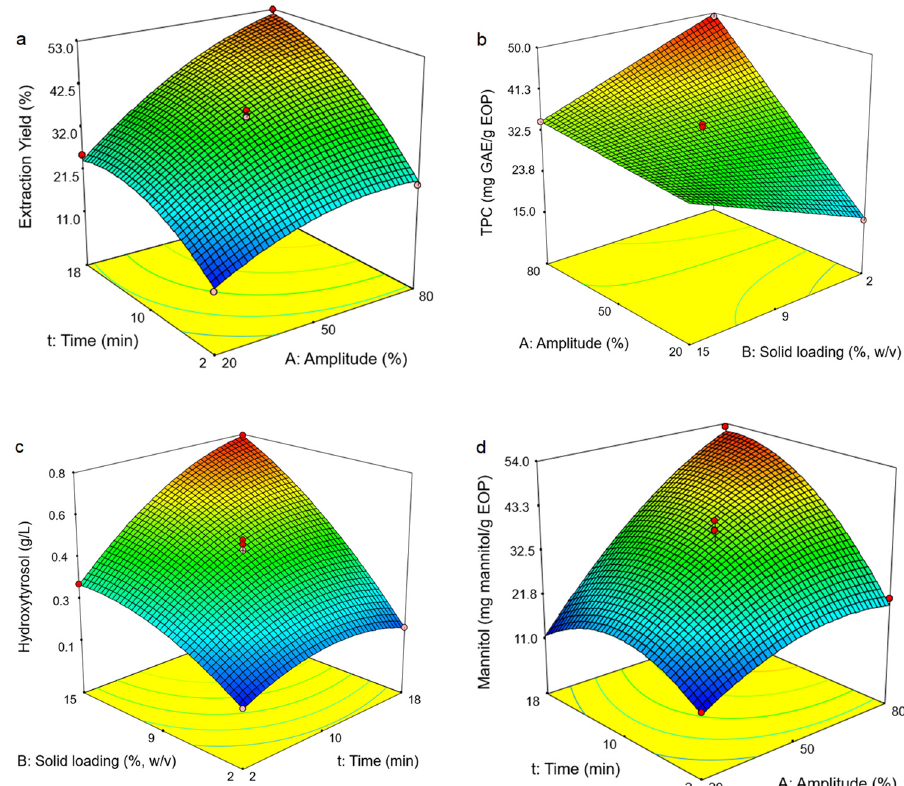
Figure 2. Response surfaces obtained by the Box–Behnken design for exhausted olive pomace: ( a ) extraction yield, ( b ) total phenolic content (TPC), ( c ) hydroxytyrosol concentration and ( d ) mannitol content. The solid loading was fixed at 8.5% ( w / v ) in plot ( a , d ), the extraction time at 10 min in plot ( b ) and the amplitude at 50% in plot ( c ).